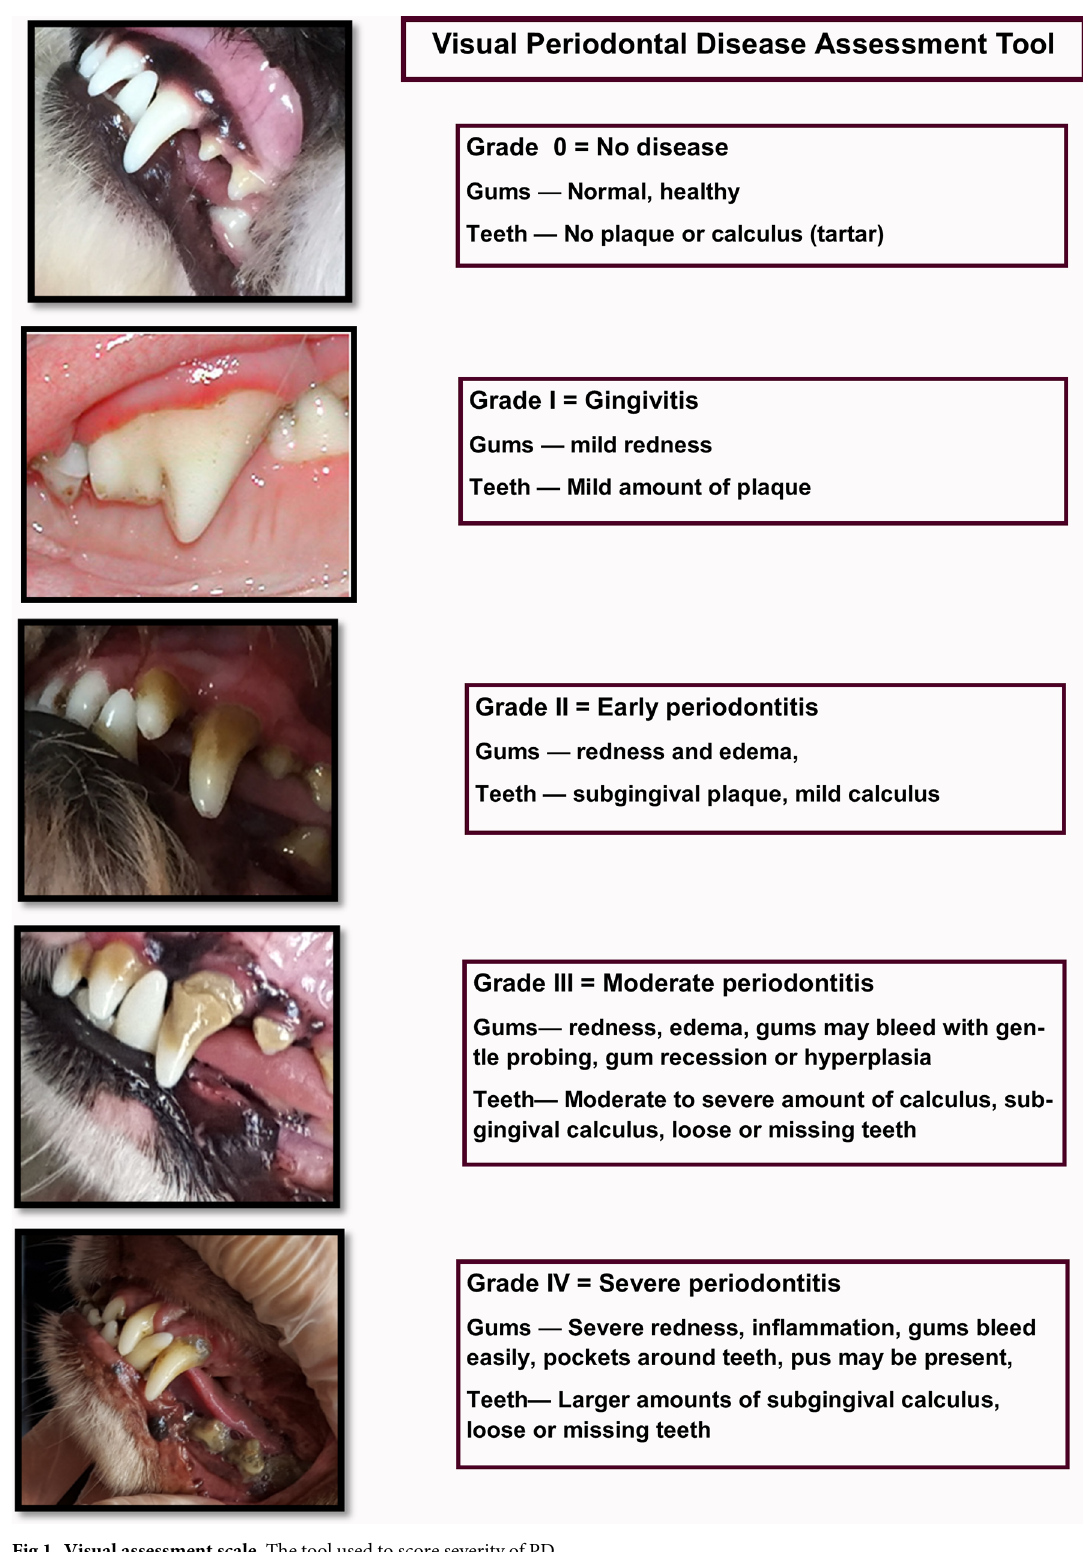
Fig 1. Visual assessment scale. The tool used to score severity of PD.